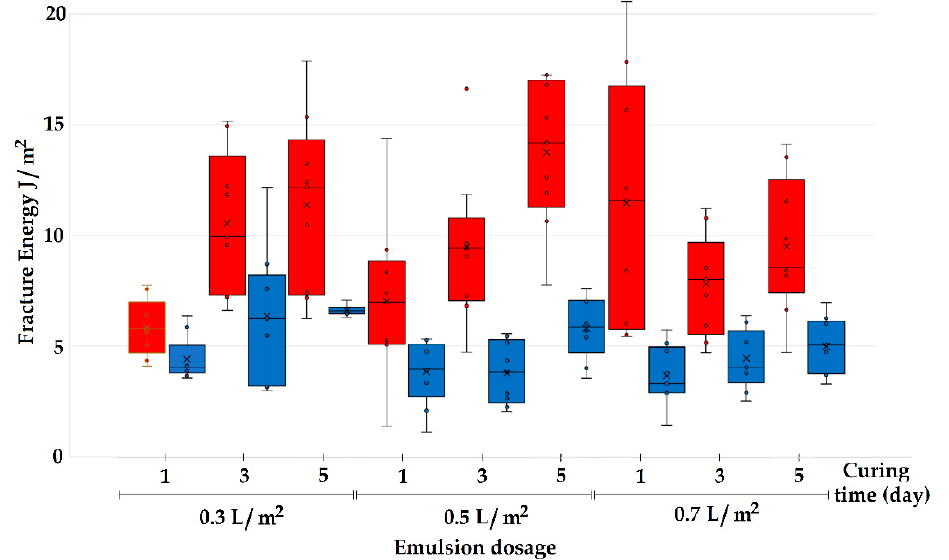
Figure 5. Box and whisker chart of the specimen fracture energy.